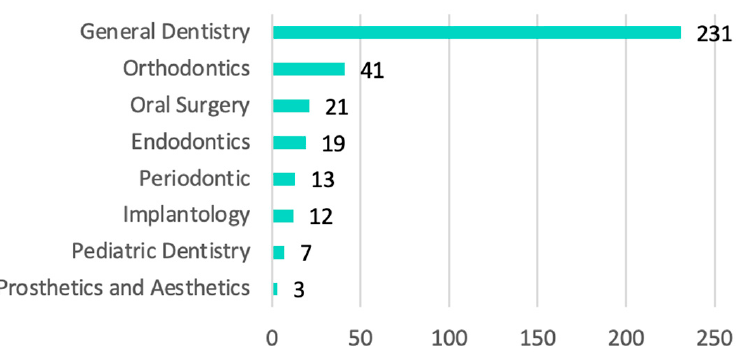
Figure 1. Preferential professional activity. Overall, 90.77% worked at between one and three clinics (one clinic: 52.16%; two clinics: 26.51%; and three clinics: 12.1%). In 96.83%, the number of dental chairs ranged between one and five. The number of clinical collaborators prior to the pandemic was mostly be- tween two and five (61.09%), and during the pandemic, 34.01% of those surveyed reported having reduced this workforce (Figure